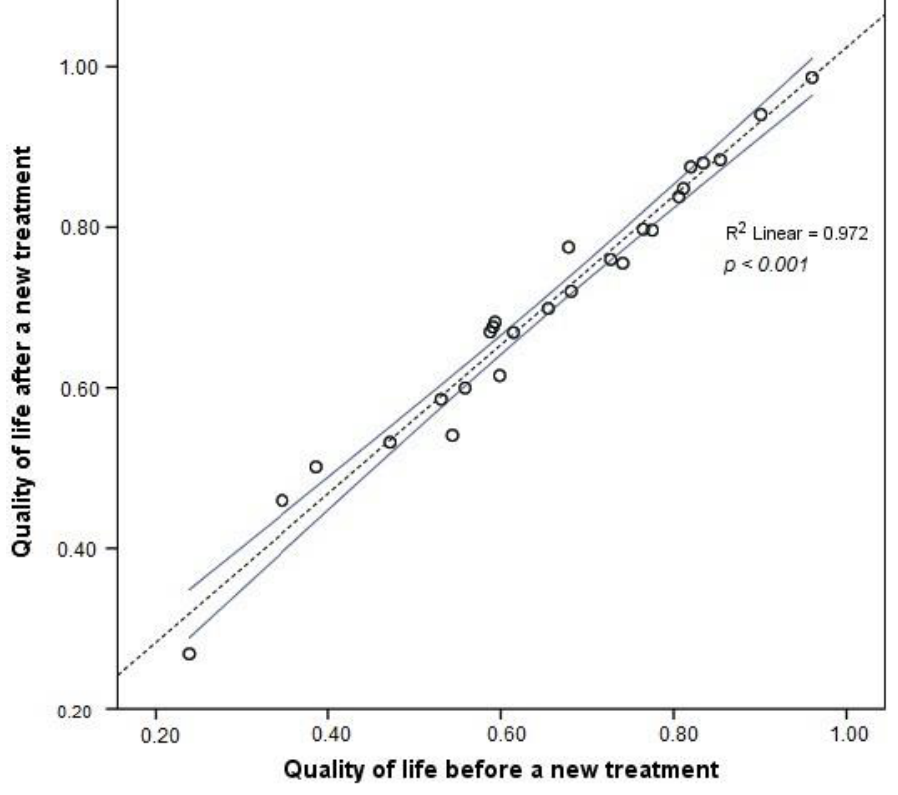
Figure 2. Correlation of QoL values before and after a new